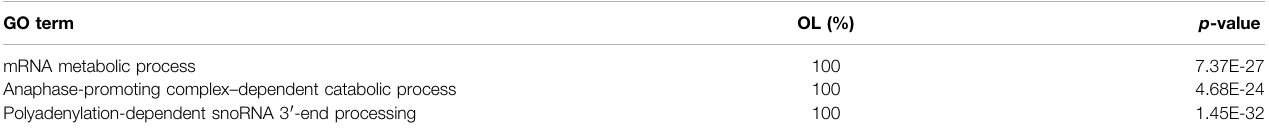
TABLE 9 | Algorithm perfectly matches the protein complex on the